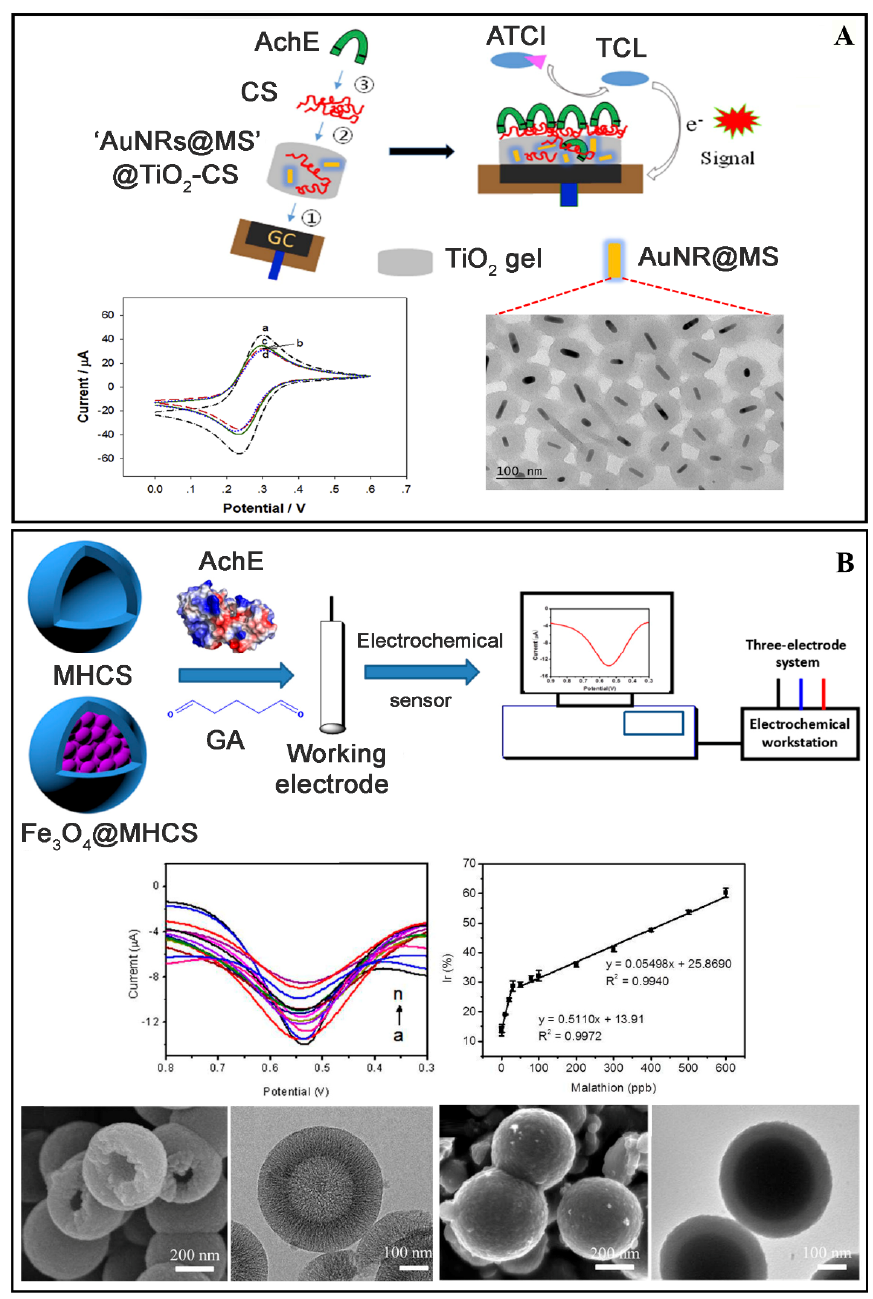
Figure 9. ( A ) Schematic illustration of the fabrication steps and the structure of the AuNRs@MS nanoparticles doped AChE biosensor and its working mechanism to acetylthiocholine evidenced the formed nanostructure and the type of electrochemical detection. Reproduced with permission from Cui et al. [38]. Copyright 2019, Elsevier. ( B ) Schematic illustration of the preparation of acetylcholinesterase (AChE)/carbon core-shell structures (Fe 3 O 4 @MHCS)/GCE electrochemical sensors. Evidenced images were obtained by Scanning electron microscopy (SEM), electrochemical detection, and analytical linearity parameter. Reproduced with permission from Luo et al. [42]. Copyright 2018, MDPI.